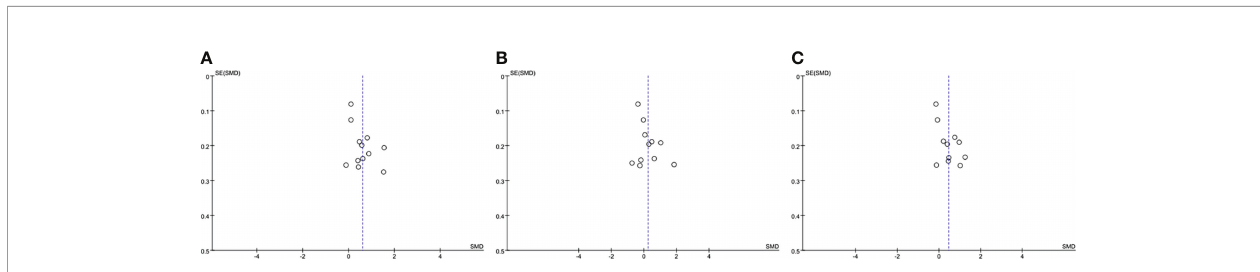
FIGURE 3 | Funnel plot analysis to detect publication bias. (A) Funnel plot for total cholesterol. (B) Funnel plot for high density lipoprotein. (C) Funnel plot for low density lipoprotein. SMD, standard mean difference.